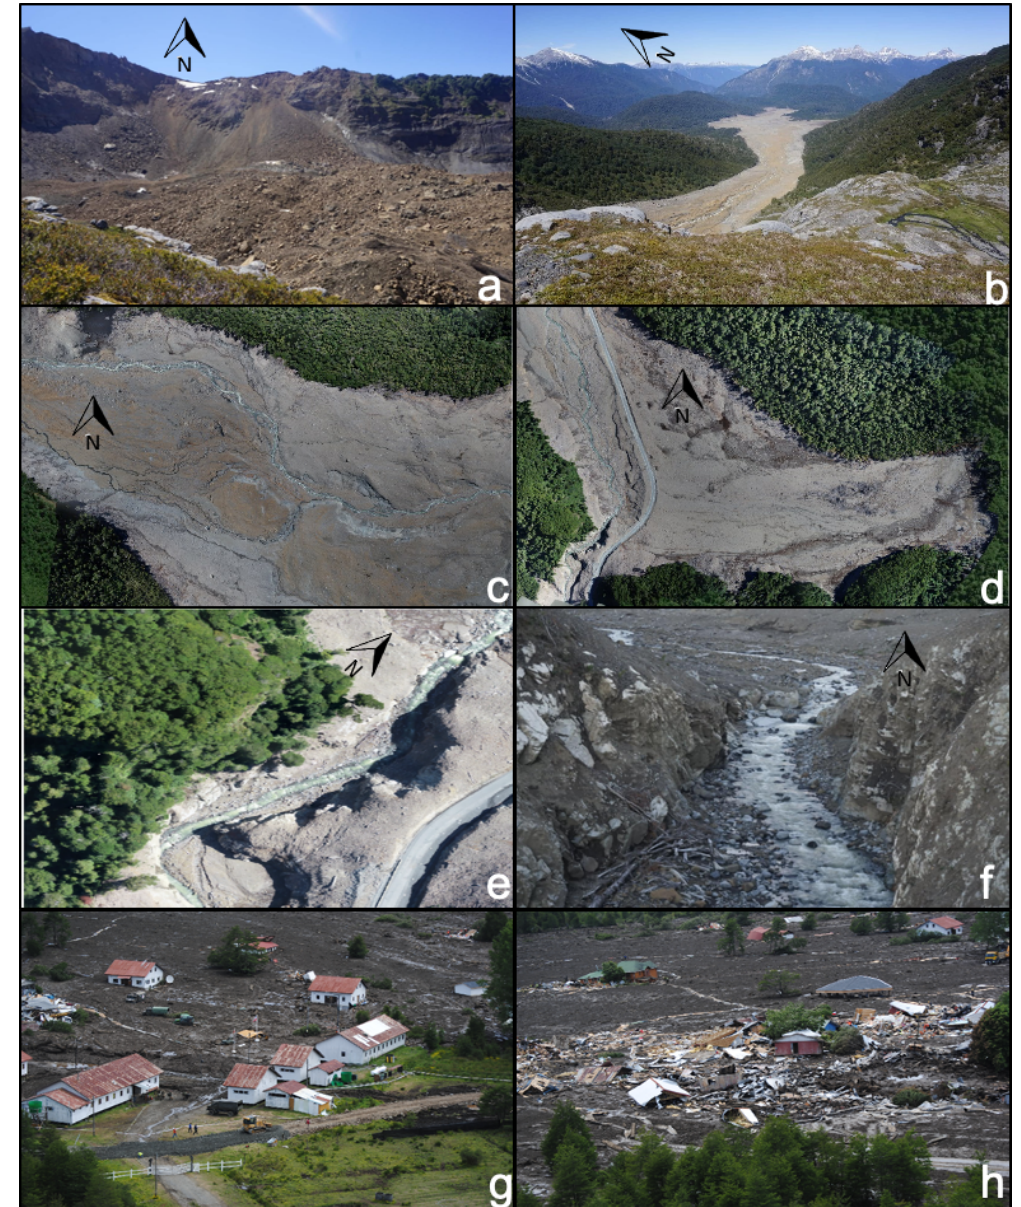
Figure 4. (a) Area of slope failure slide and deposit; (b) channeled flow at the foothills; (c, d) aerial photo of nonchanneled flood deposited in an old wetland captured with an Inspire II UAV; (e, f) photos of the channel in the last section before entering Villa Santa Lucía: (e) captured with an Inspire II UAV and (f) picture of the channel facing downstream. (h, i) Villa Santa Lucía after the mudflow (from Sernageomin,